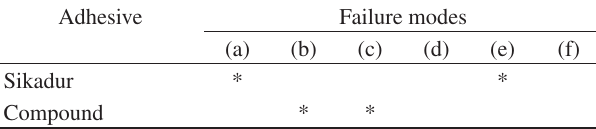
Table 3. Failure modes recorded in fatigue tests – Eucalyptus citriodora.